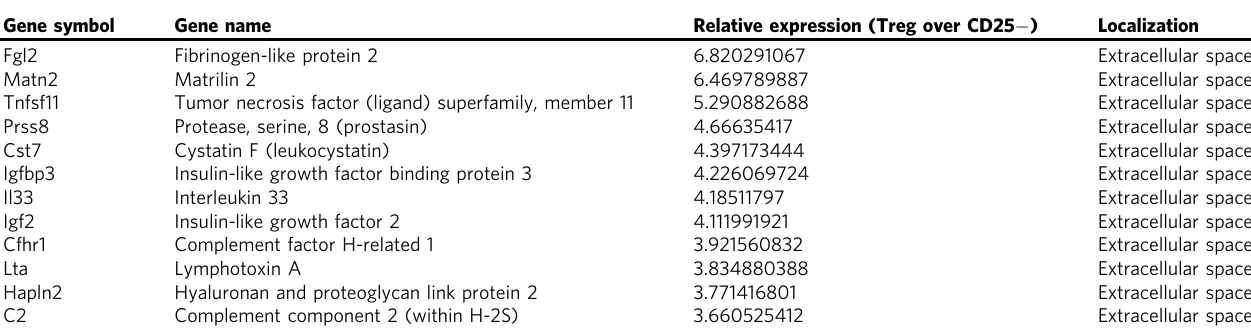
Table 1 Secreted proteins highly expressed by Treg cells compared to CD4 + /CD25 − cells Gene symbol